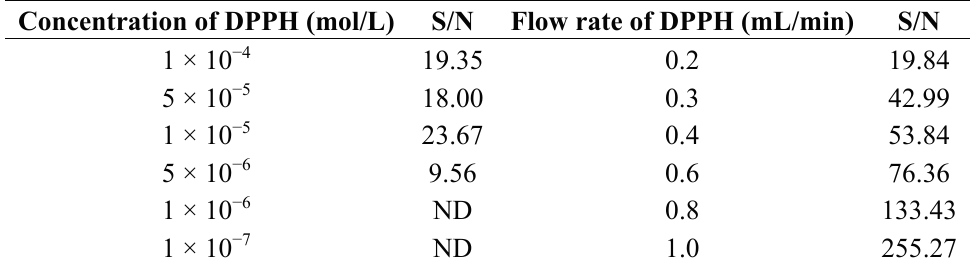
Table 1. The signal-to-noise ratio (S/N) values of baicalein-7- O -gentiobioside under different concentrations and flow rates of DPPH.